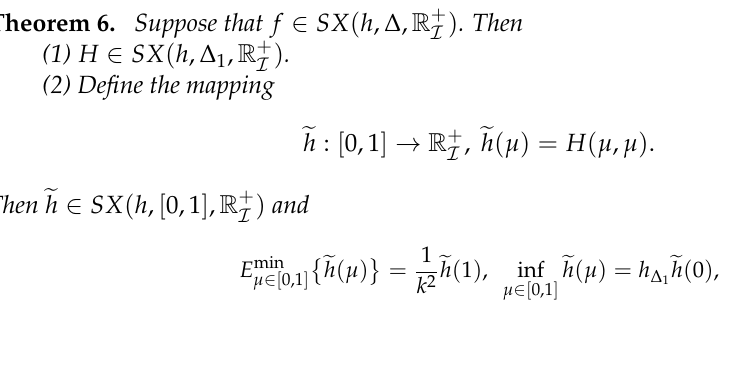
Figure 2. Illustration of Example 3: Let f ( s , t ) = (cid:16) ( 1 + µ ) 3 2 − ( 1 − µ ) 3 2 8 H ( µ , ν ) = ≤ H ( µ , ν ) ≤ have 64 9